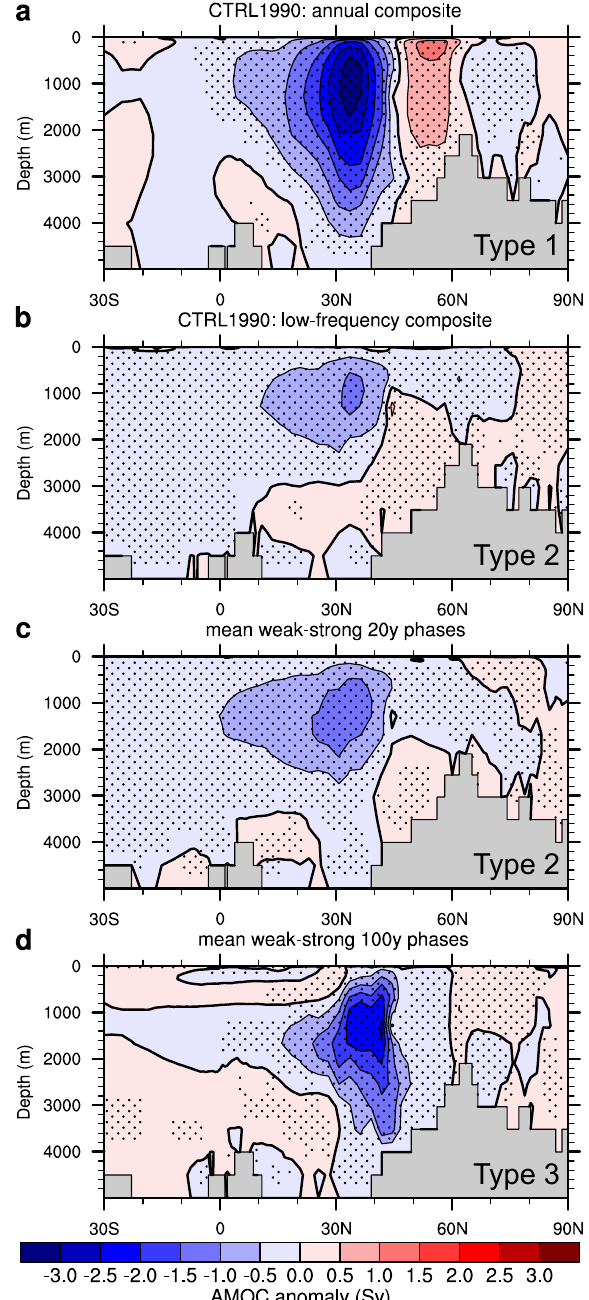
Fig. 6. The mean variability pattern of the AMOC: (a) difference between the composite of all years where the annual AMOC index is at least one Stdd below the mean and the composite of all years where it exceeds the mean by one Stdd for the CTRL1990 simula- tion (Type 1), (b) as (a) but using the low-pass filtered time series to determine the composite (Type 2), (c) mean difference pattern of the weak and the strong AMOC phases (using 20 year periods prior to and after the transition) averaged over all Type 2 transitions in- dicated in Fig. 5, (d) as (c) for the Type 3 transitions and using 100 years periods to reduced the impact of noise. The stippled areas are significant at the 5% level based on the two-sided Student’s